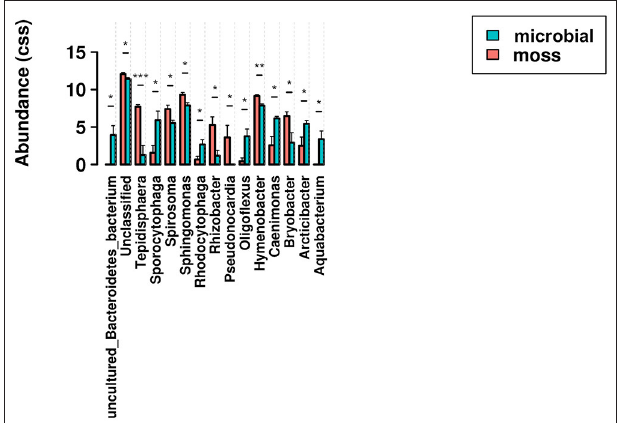
Frontiers in Ecology and Evolution |